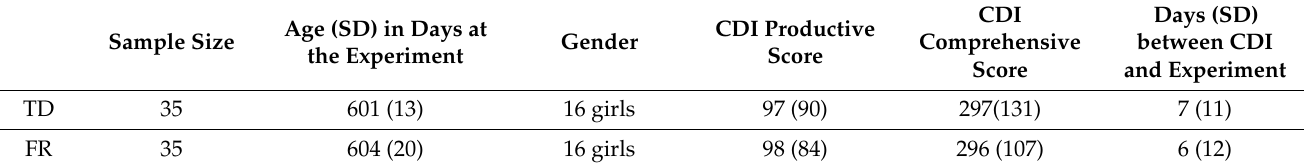
Table 1. Characteristics of the typically developing (TD) andchildren at familial risk of dyslexia (FR). CDI = Dutch version McArthur Communicative Development